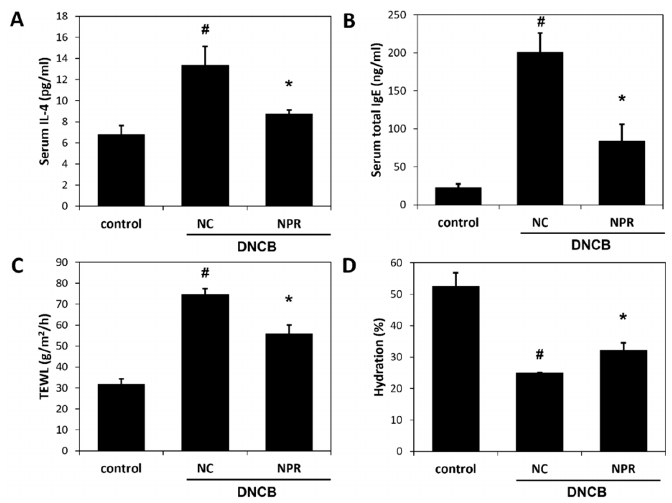
Figure 4. E ff ect of NPR extract on serum IL-4 and IgE levels and skin barrier function in SKH-1 hairless mice. ( A , B ) Serum total IL-4 and IgE levels were measured by collecting serum samples on the last day of the experiment using an ELISA kit. ( C ) TEWL and ( D ) skin hydration of dorsal skins were monitored during the 4-week period using Tewameter TM210 and SKIN-O-MAT instruments. Results are expressed as the means ± SEs of 2 to 3 independent experiments. # p < 0.05 vs. untreated control group; * p < 0.05 vs. DNCB-treated mice. control: untreated control group; NC: DNCB-treated negative control group; NPR: DNCB plus N. peltata root extract-treated group.